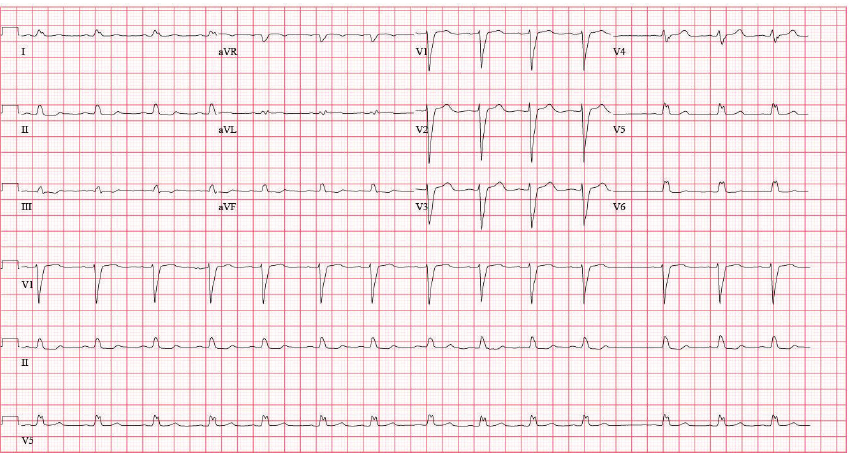
Figure 3: EKG tracing at 3-year follow-up showing persistence of left bundle branch block with heart rate of 84/minute, PR interval of 142 milliseconds, QRS duration of 126 milliseconds, and QTc of 377